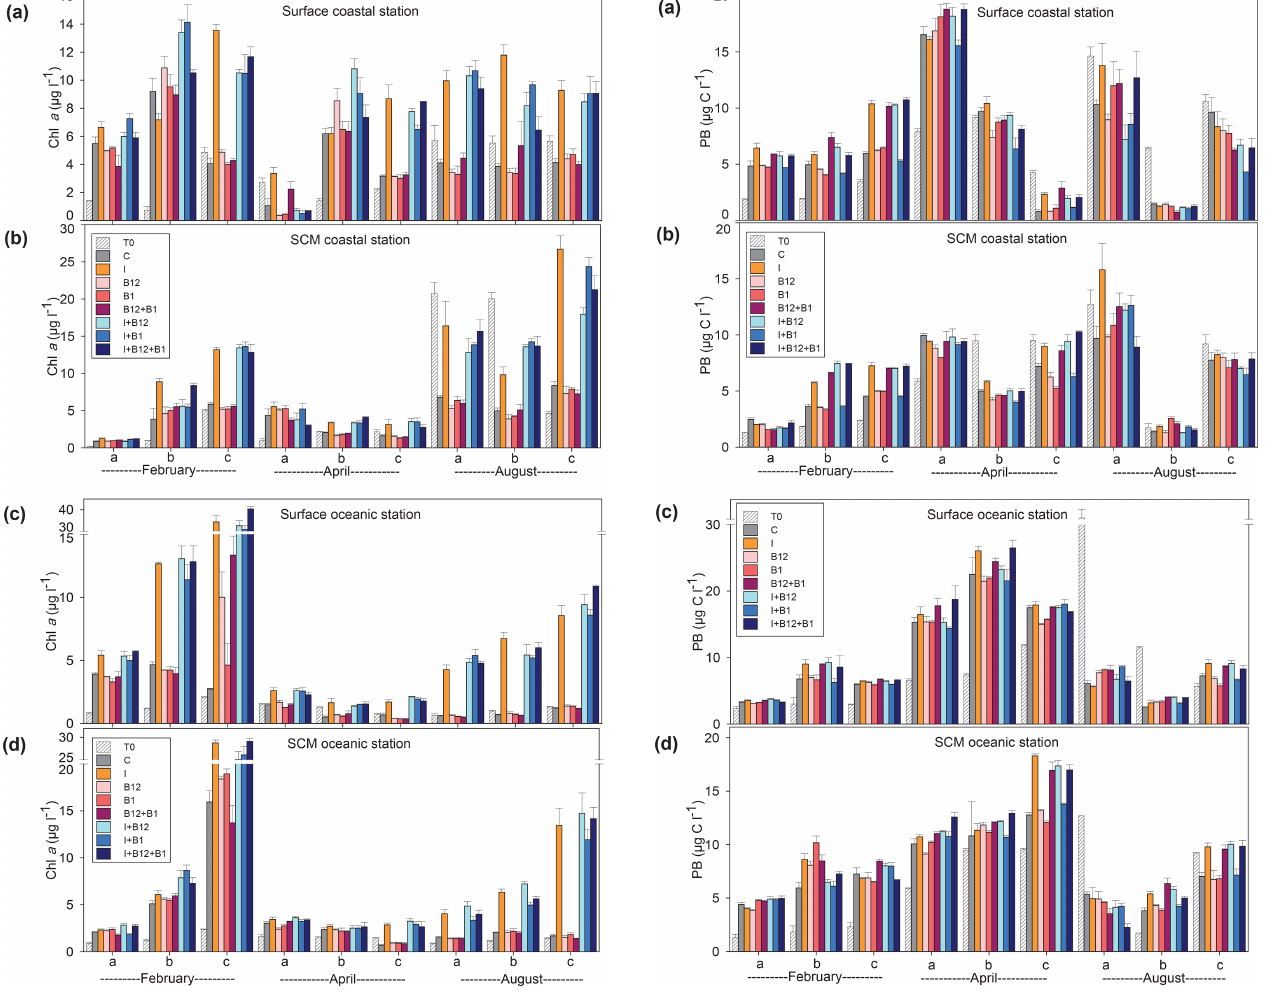
Figure 5. Chlorophyll a concentration (µgL − 1 ) in the t 0 of each experiment (striped bars) and in the endpoint of each treatment (col- ored bars) in the experiments conducted at (a) surface and (b) SCM depth in the coastal station and at (c) surface and (d) SCM depth in the oceanic station in February, April and August. Error bars repre- sent standard error. Note that the y axis is broken. SCM: subsurface chlorophyll maximum.